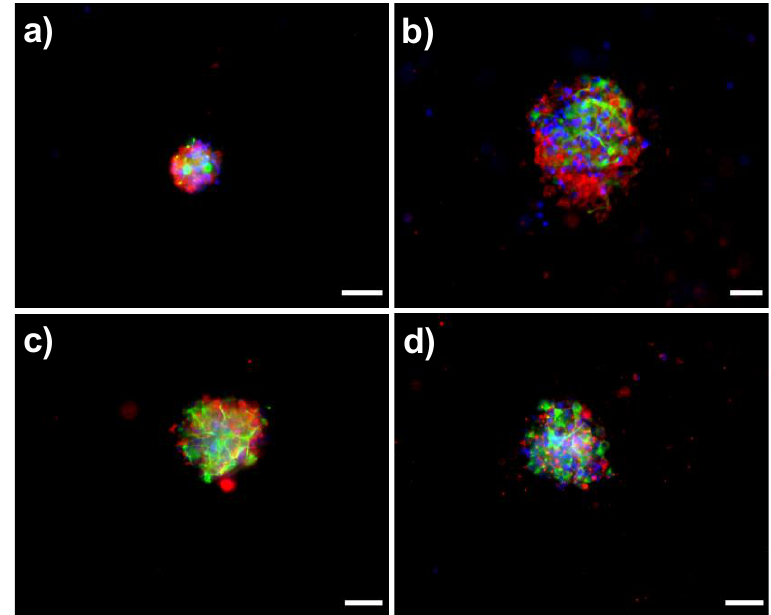
Figure 6. Epifluorescence microscopy images of differentiated neural stem progenitor cells (NSPC) into PCL fibrous mats: pristine PCL 394 ( a ), and those prepared in the presence of PEO 45 -b- PCL 11 ( b ), PEO 148 -b- PCL 13 ( c ), and PEO 230 -b- PCL 184 ( d ). Scale bar is 100 µm. Red marks are associated to β-III tubulin positive cells (neuroblasts / neurons); green marks to GFAP positive cells (glioblasts / astrocytes); and blue marks to cell nucleus (DAPI).